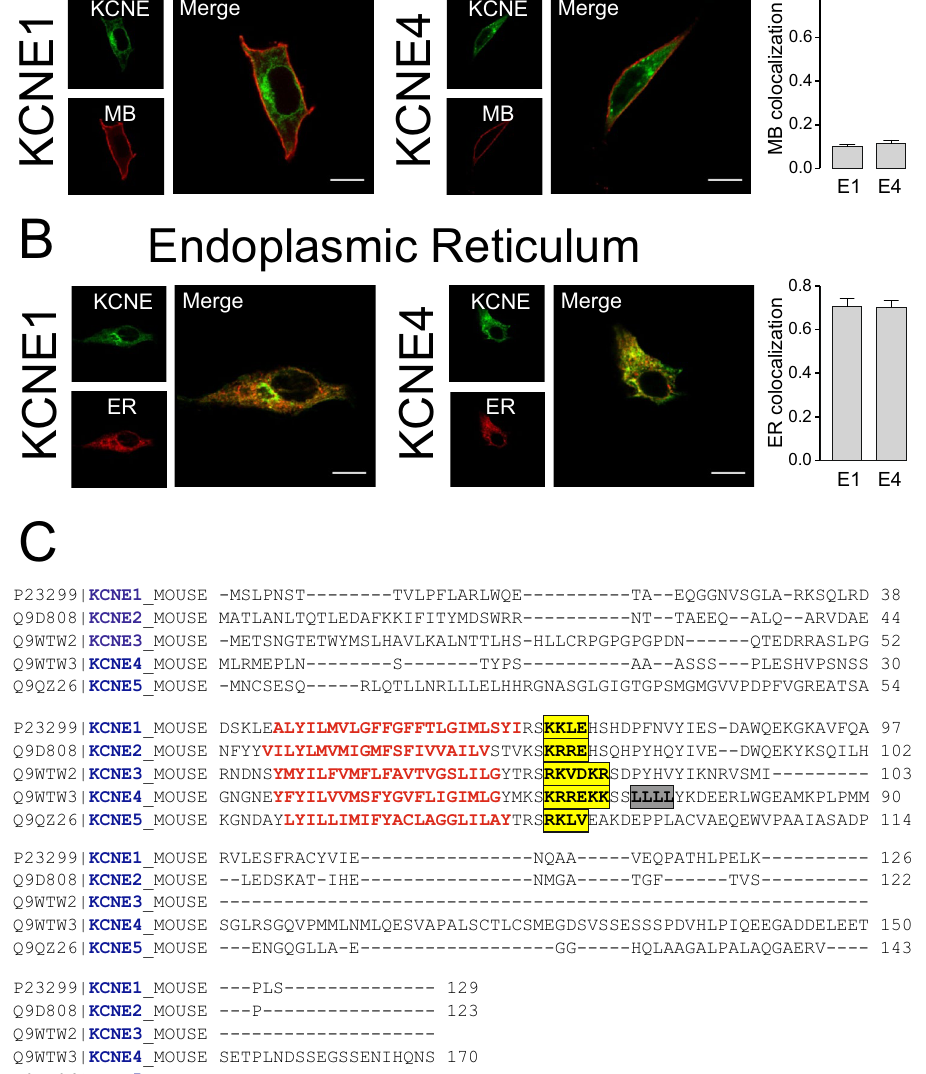
Figure 2. KCNE1 and KCNE4 exhibit notable endoplasmic reticulum retention. Representative confocal images of HEK-293 cells transfected with KCNE1 and KCNE4. ( A ) KCNE-transfected cells were cotransfected with a plasma membrane marker (MB). ( B ) KCNE-transfected HEK-293 cells were cotransfected with an endoplasmic reticulum marker (ER). Right panels, KCNE1; center panels, KCNE4; left panels, histograms showing the colocalization between KCNEs (E1 and E4) and markers (MB and ER) based on Mander’s coefficient analysis. The values represent the mean of > 40 cells. Green, KCNEs; red, cell markers; yellow, merged image. Bars represent 10 μm. ( C ) Sequence alignment of murine KCNE peptides. KCNE1 (UniProtKB: P23299); KCNE2 (UniProtKB: Q9D808); KCNE3 (UniProtKB: Q9WTW2); KCNE4 (UniProtKB: Q9WTW3); KCNE5 (UniProtKB: Q9QZ26). Mouse sequences are shown because murine isoforms were used throughout the study, and the results obtained were similar to the results with human isoforms. Transmembrane segments are highlighted in red. The ER-retention motifs are boxed in yellow. The specific tetraleucine motif identified in KCNE4 is colored